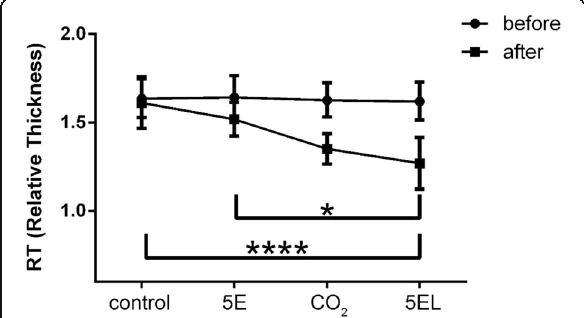
Fig. 5 Comparison of relative thickness of rabbit hypertrophic scars before and after applied different treatments. 5EL: the enthosomal gels encapsulated with 5-FU combined with CO 2 fractional laser, n =14; CO 2 : CO 2 fractional laser only, n =12; 5E group: the enthosomal gels encapsulated with 5-FU, n =14; control: blank, n =16. * p value <0.001 was considered significant, **** p value < 0.0001 was considered statistically highly extremely